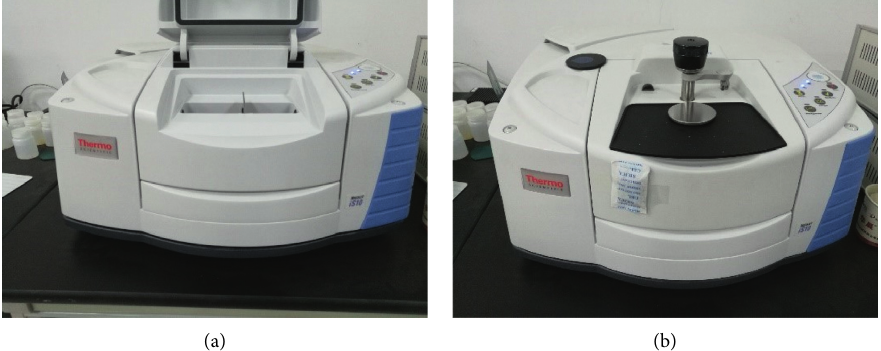
Figure 2: ThermoNicolet 380 Fourier transform infrared spectrometer: (a) solid analysis unit; (b) liquid analysis unit.